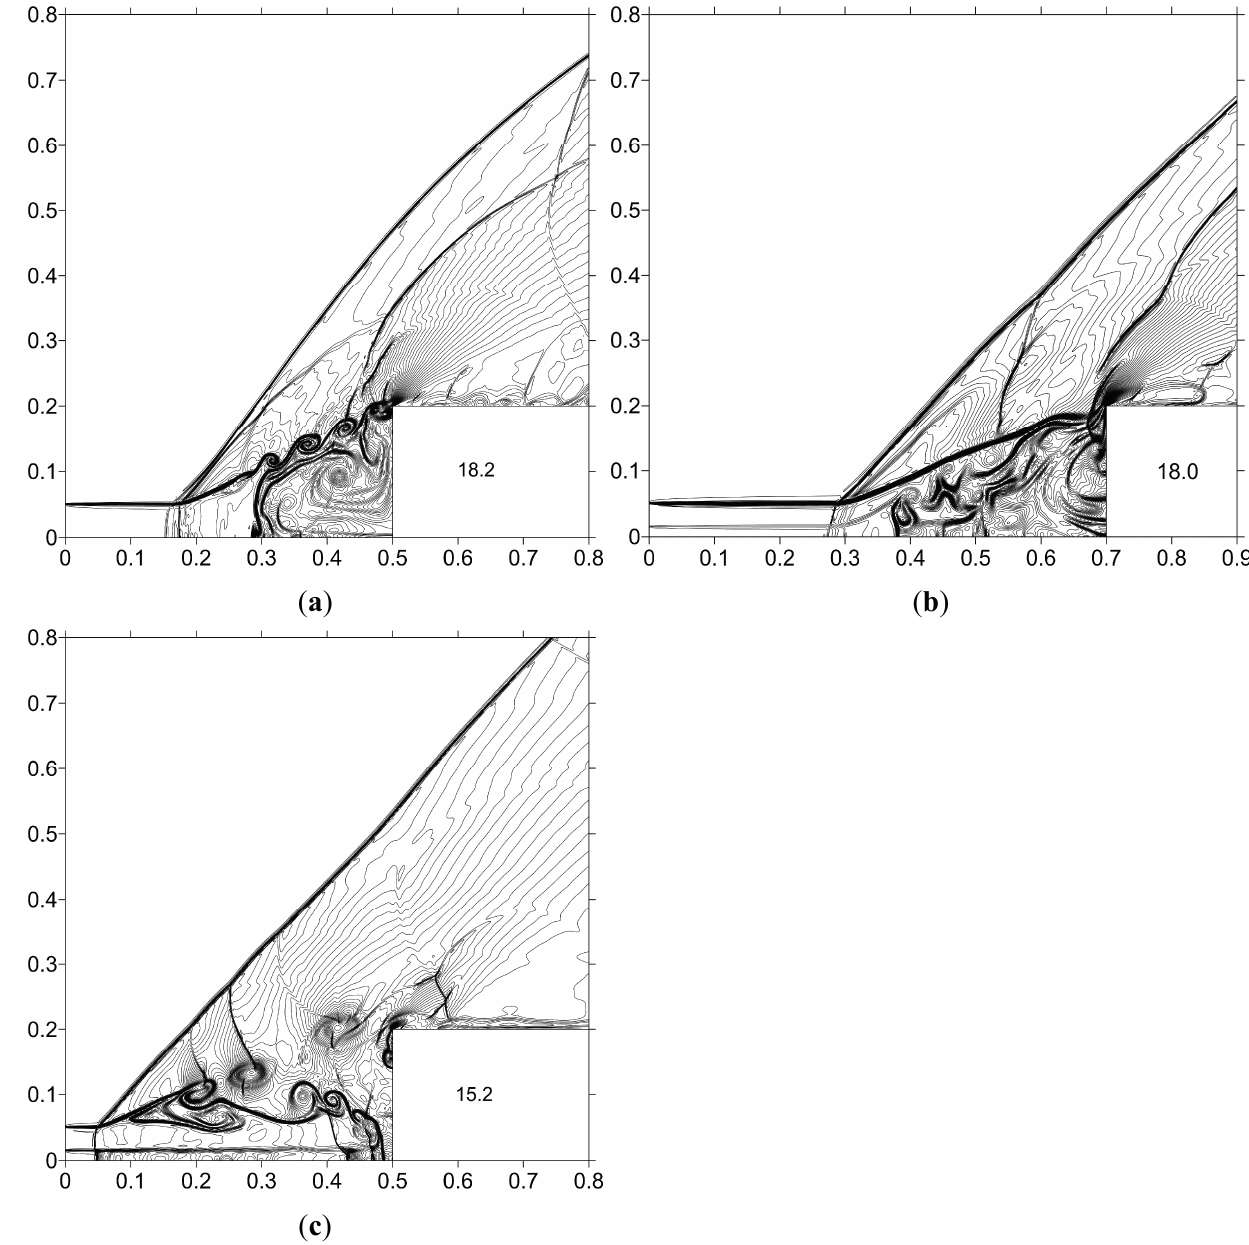
Figure 5. Density contours, M = 1.89, α ρ = 0.5: ( a ) Non-combined filament; ( b ) Combined filament, α ρ 1 = 0.4; ( c ) Combined filament, α ρ 1 =